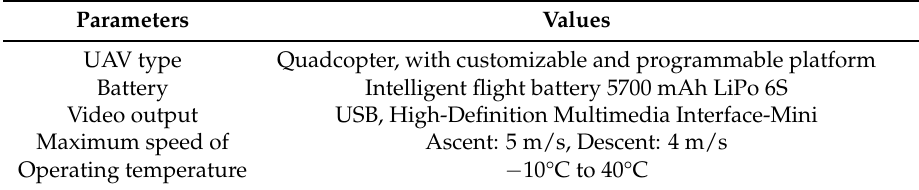
Table 1. Technical specifications for the DJI Matrice